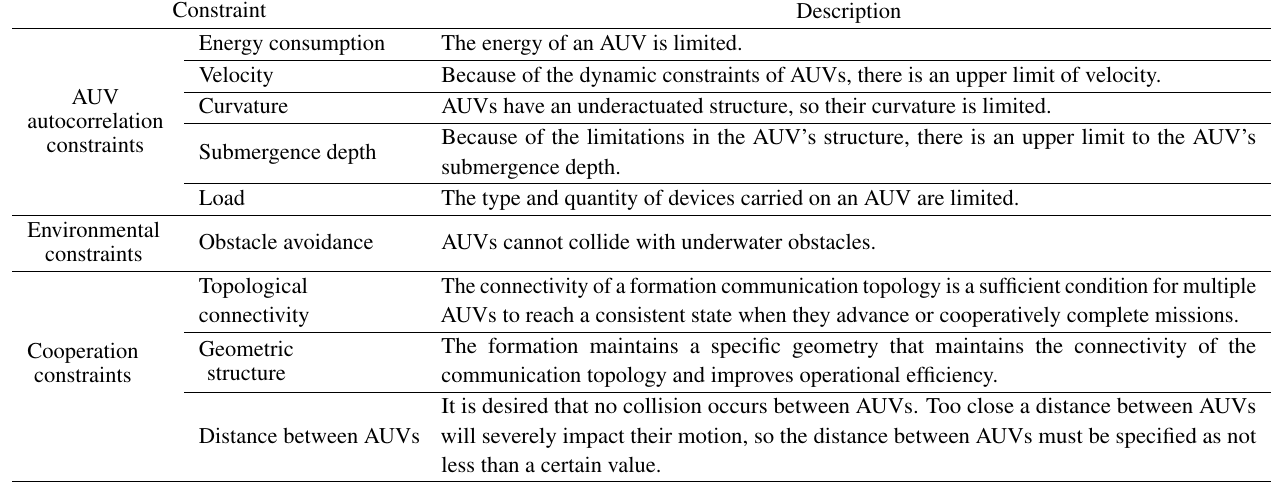
Table 3 Main constraints in multi-AUV formation transformation